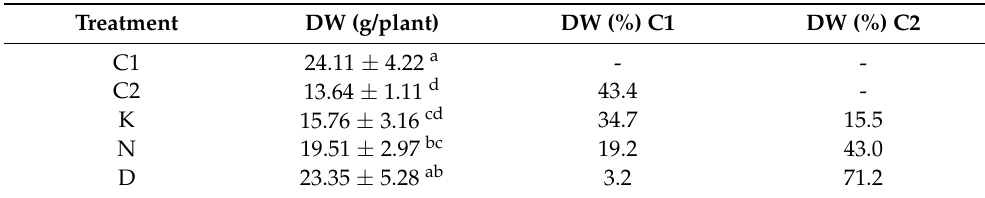
weight of whole plant (g/plant) (DW (g/plant), dry weight of whole plant (g/plant) compared to